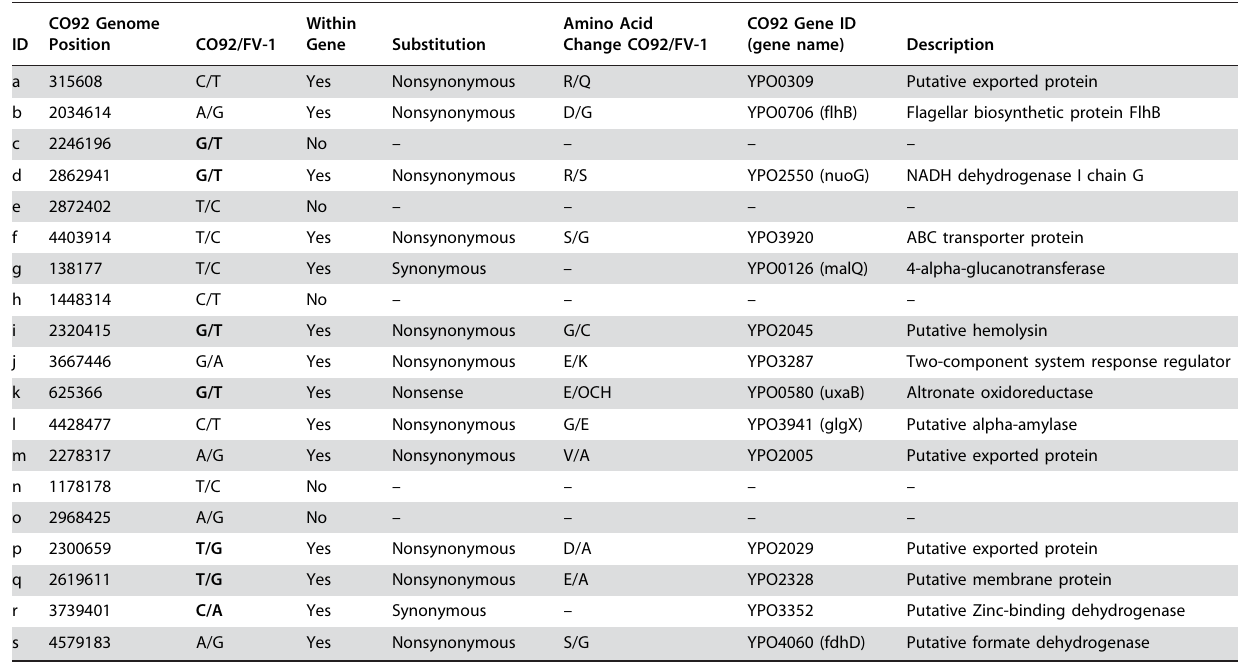
Bold=transversion mutation